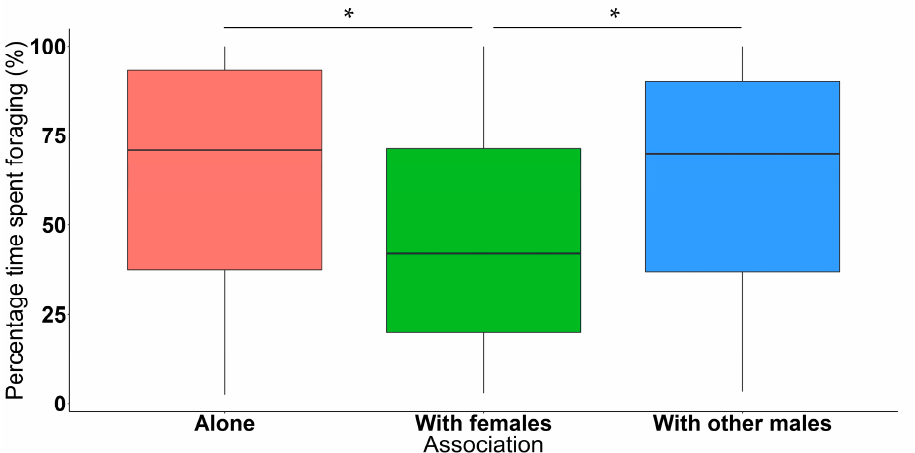
Figure 5. Boxplot depicting the percentage time spent foraging (%) across different associated social groups. Number of observations = 428. * Indicates statistically significant differences between groups.